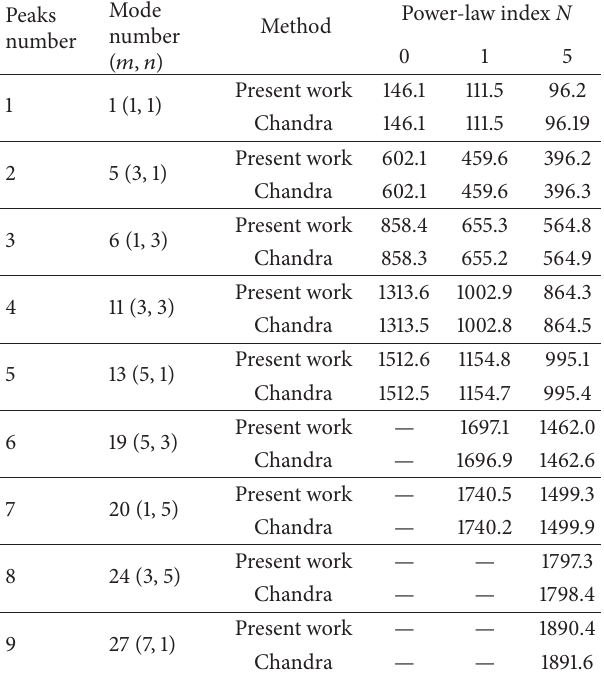
Table 1: Structural modes corresponding to the peaks in Figure 6: comparison between the present work and Chandra et al. [22].